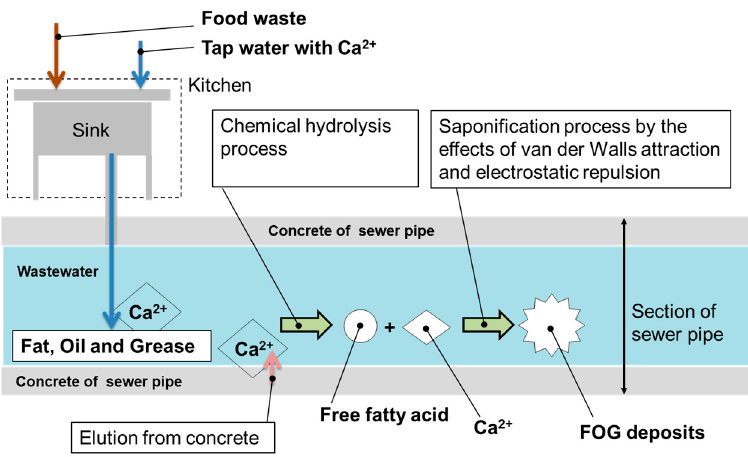
Figure 1. Proposed mechanism of fat, oil, and grease deposit formation in sewer lines [12].